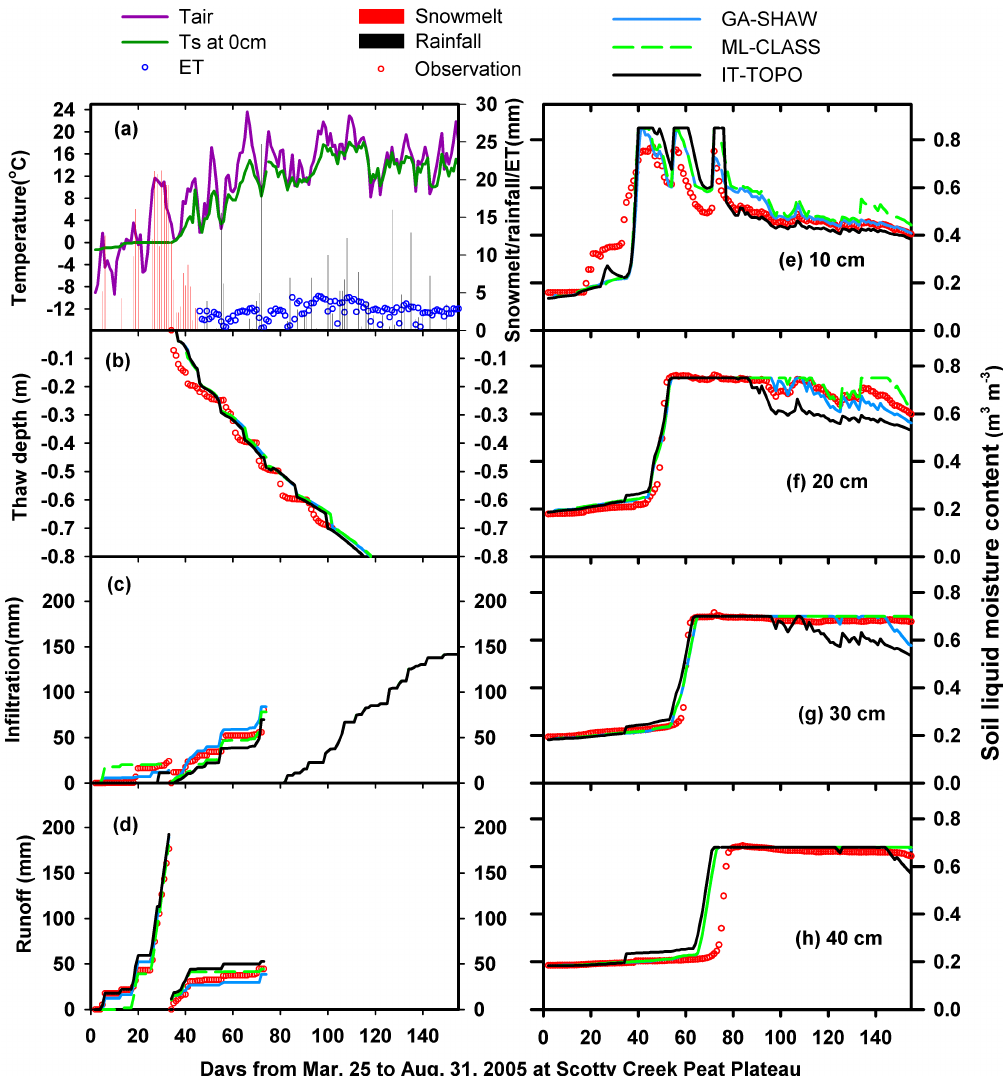
Fig. 5. Surface forcing variables (a) , observed and simulated ground thaw depths (b) , cumulative infiltration (c) and runoff (d) at three thawing stages, and liquid soil water content at the monitoring depths ( e , f , g and h ) at Scotty Creek peat plateau